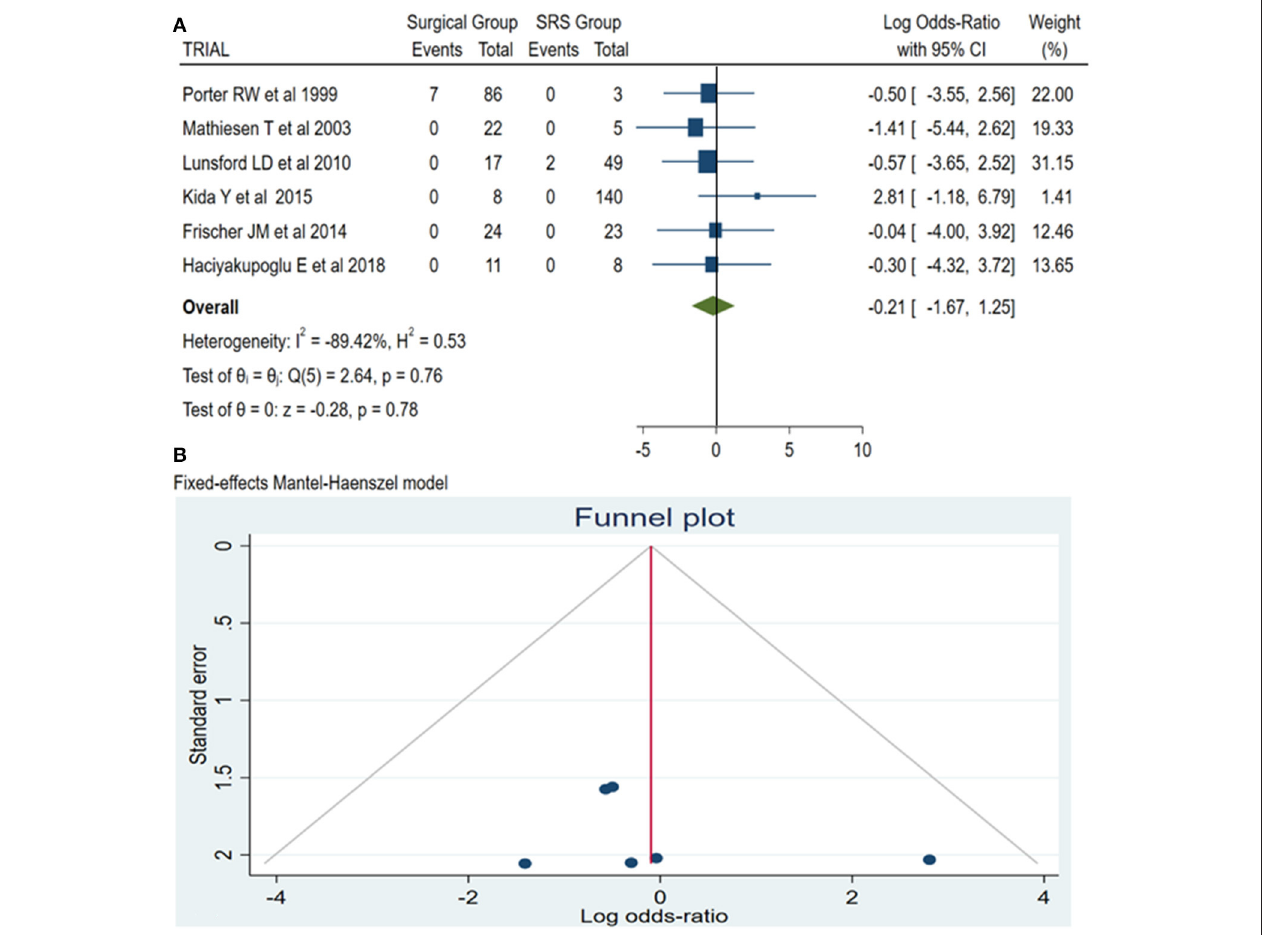
FIGURE 6 | Mortality: (A) OR forest plot mortality: Results demonstrate no statistically significant difference between the two groups (log OR − 0.21, CI 95% 1.25–1.67, and p = 0.78) with no heterogeneity ( p = 0.76 and I 2 = − 89.42%); (B) Funnel plot of the same parameter demonstrated no publication bias. SRS, Radiosurgical group; I 2 shows the percentage of total variation across studies that is due to heterogeneity rather than chance; CI, confidence